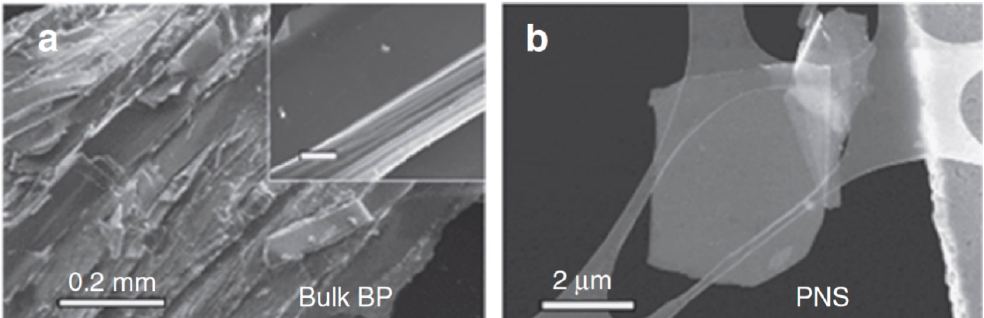
Figure 4. ( a ) Scanning electron microscopy (SEM) image of bulk BP. The inset is a magnified image showing the layered structure; scale bar, 10 μ m; ( b ) SEM image of exfoliated BP nanosheets. Reproduced from Ref. [90]. Published by Macmillan Publishers Limited as open access,